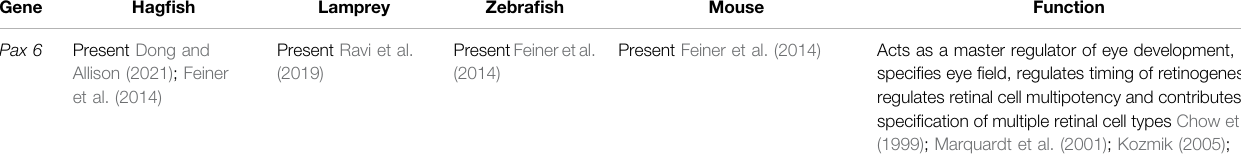
TABLE 1 | Retinal homeobox genes across representative